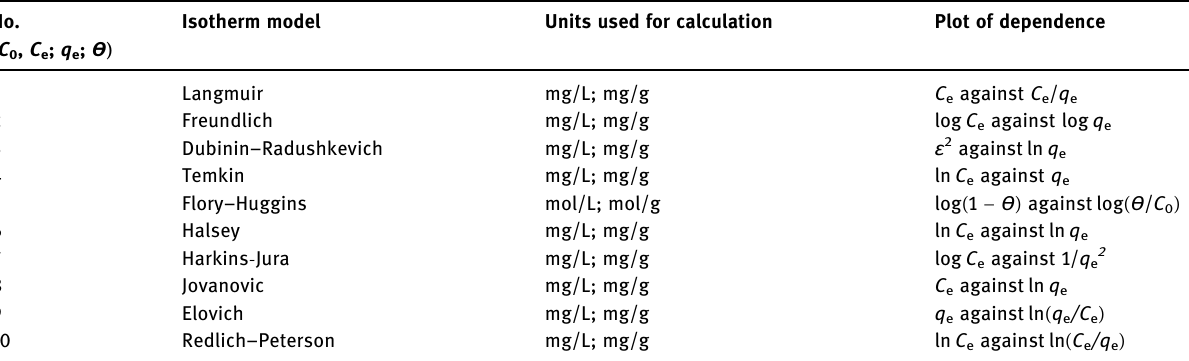
Table 1: The conditions of calculation and plotting curves to test fi t of selected isotherm models ( Meaning of basic symbols: C e is concentration of adsorbate at equilibrium, q e is amount of adsorbate adsorbed at equilibrium, C 0 is adsorbate initial concentration, Θ is degree of surface coverage; other appearing symbols belong to individual constants or indicators. )